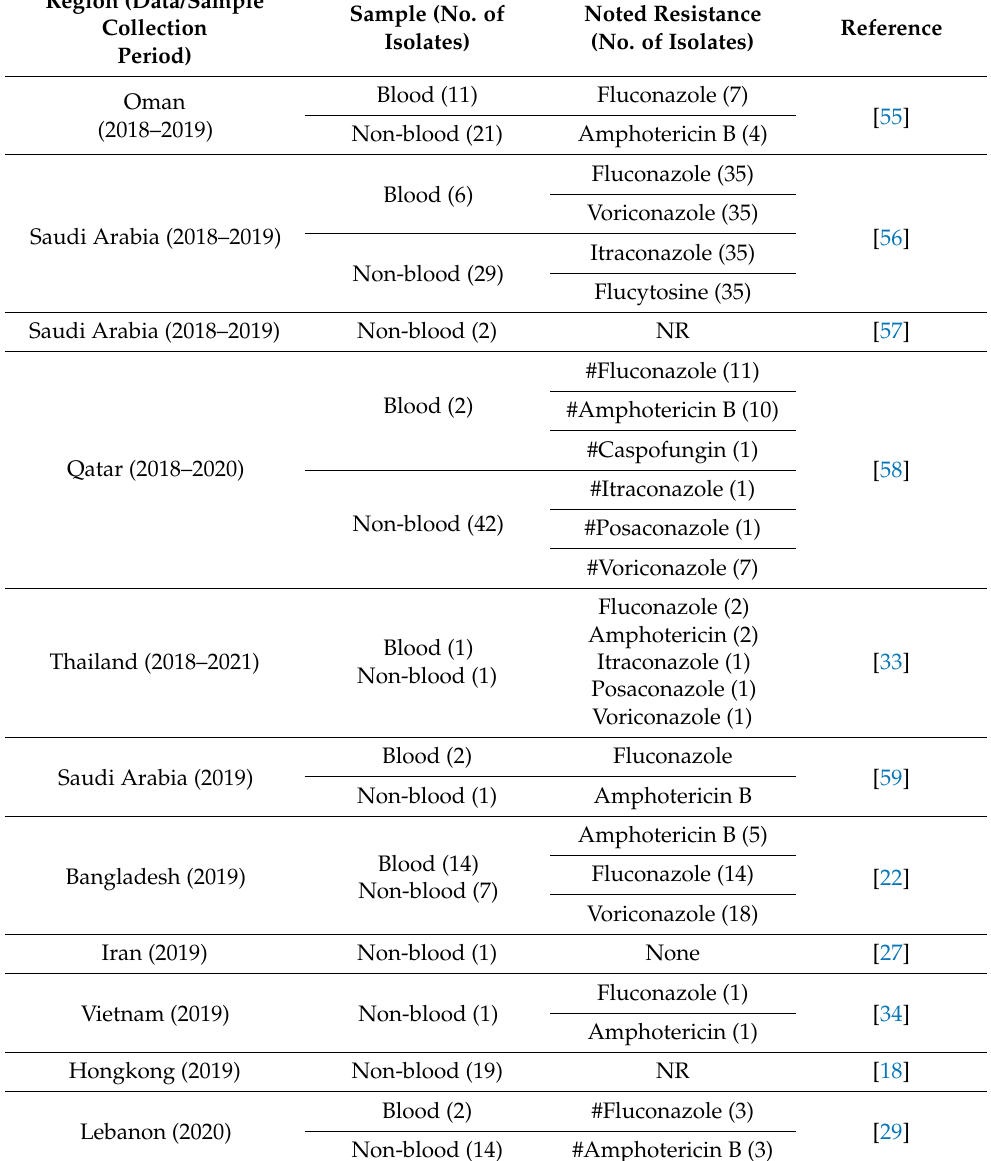
Table 1. Cont. Region